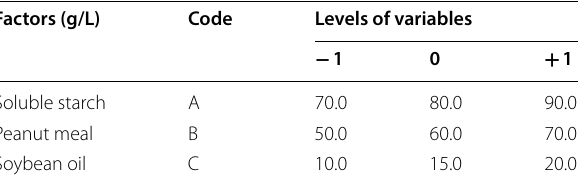
Table 1 Independent variables and different levels used